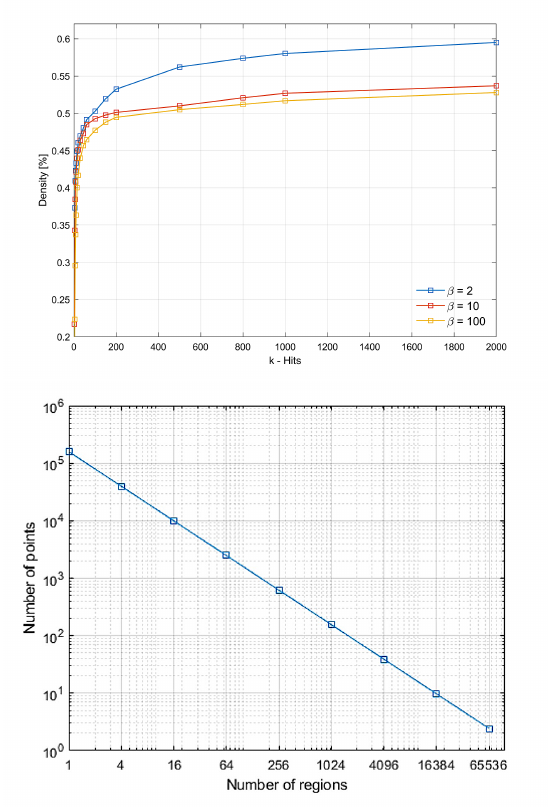
Figure 3. The density of points in function of k -hits show the increasing packing density with increasing k number (upper image). The average numbers of points in different number of squares (lower